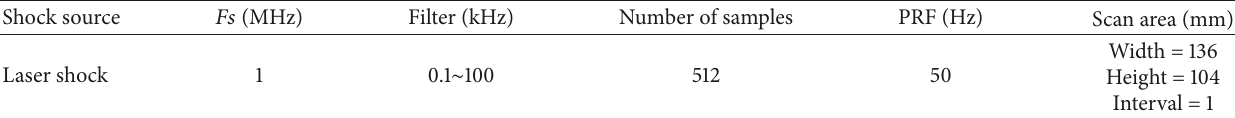
Table 3: Measurement condition of laser shock for reconstruction of pyroshock on the disk type